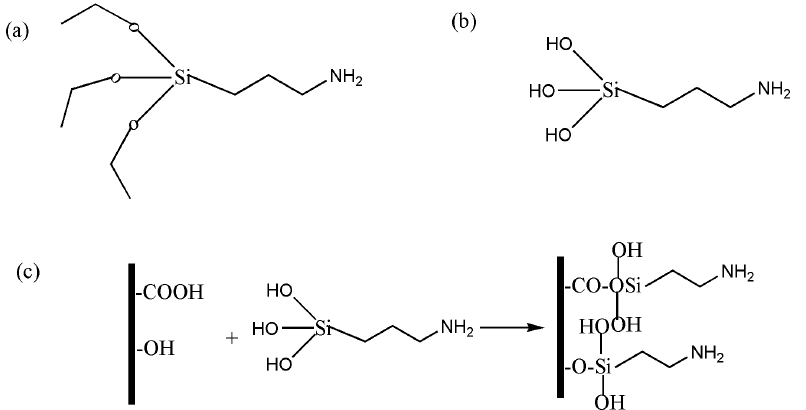
Figure 5. ( a ) chemical structures of KH550; ( b ) Schematic illustration of the hydrolysis of KH550 and ( c ) the reaction of KH550 with fabrics.